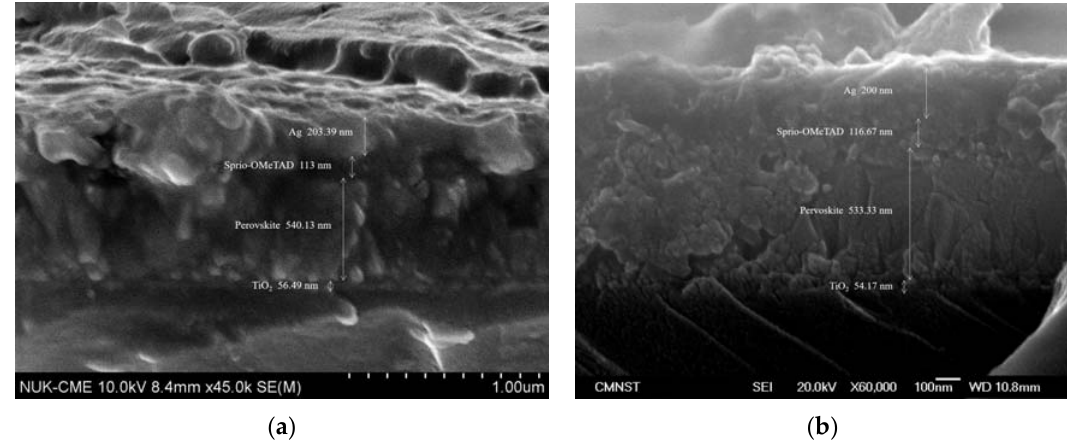
Figure 4. The UV-vis absorption spectrum of original and double concentration of TiO 2 in various spin-coating speeds.